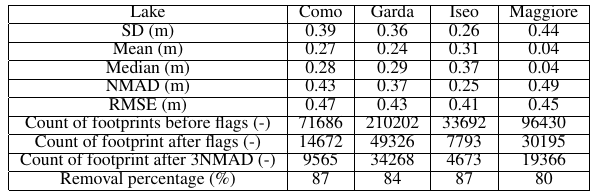
Table 1. Overall statistics for the water level differences between gauge measurements and medians of GEDI measurements (standard deviation (SD), mean, median, and root mean squared error (RMSE) for each lake.) after outliers removal over the whole period of 2019/06 – 2022/06 for 3 lakes of Northern Italy (Como, Garda, and Iseo)